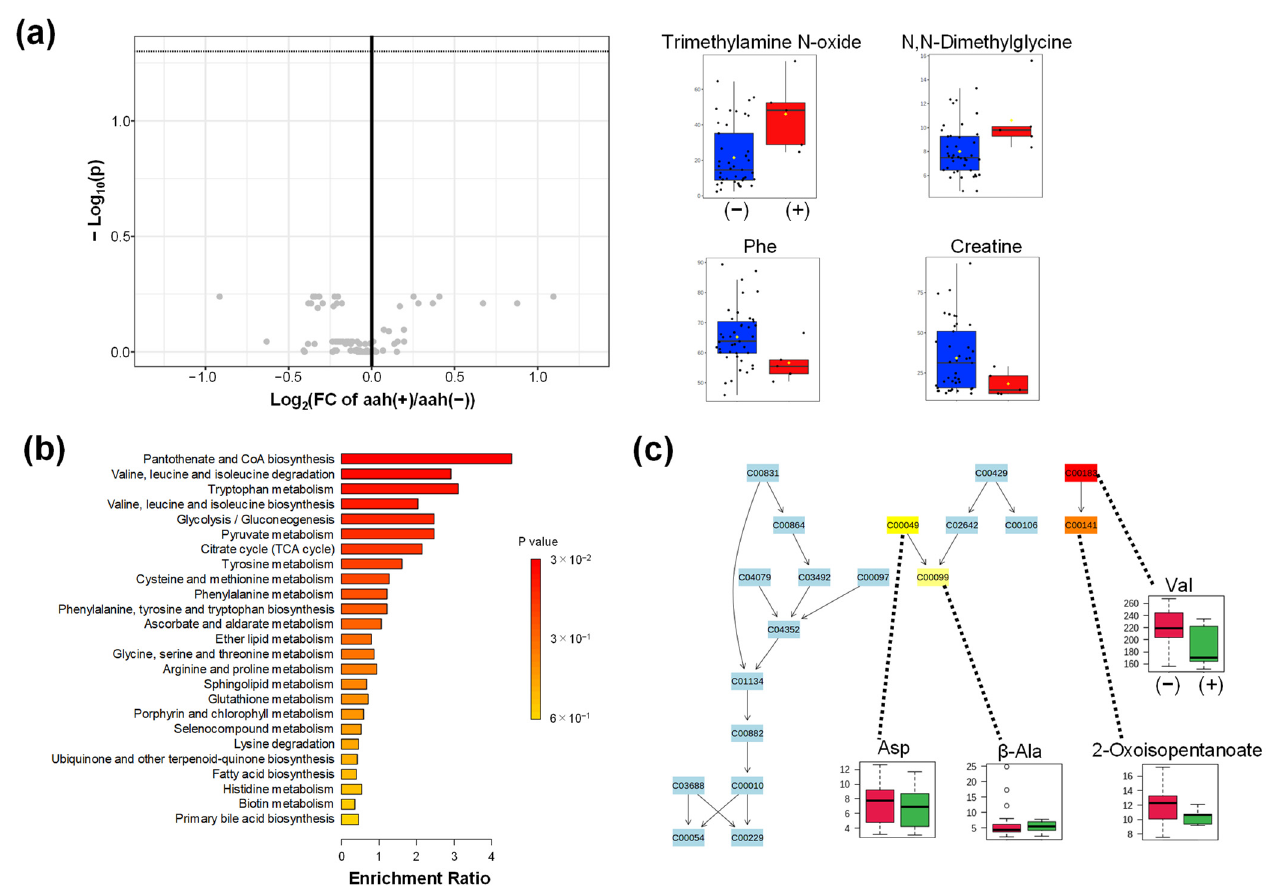
Figure A4. The difference in the metabolomic profile of participants with kidney transplantation (groups S aah (+) and aah ( − )). ( a ) Volcano plots. The x -axis indicates the log 2 -fold change (FC) of aah (+)/aah ( − ). The y -axis shows the − log 10 (P) of each metabolite. FDR-adjusted p -value was calculated using the Mann–Whitney test. Metabolites showing p < 0.05 without correction are shown using box plots; ( b ) Enrichment analysis; ( c ) Pantothenate and CoA biosynthesis showing the largest − log 10 (P) value by the pathway analysis.